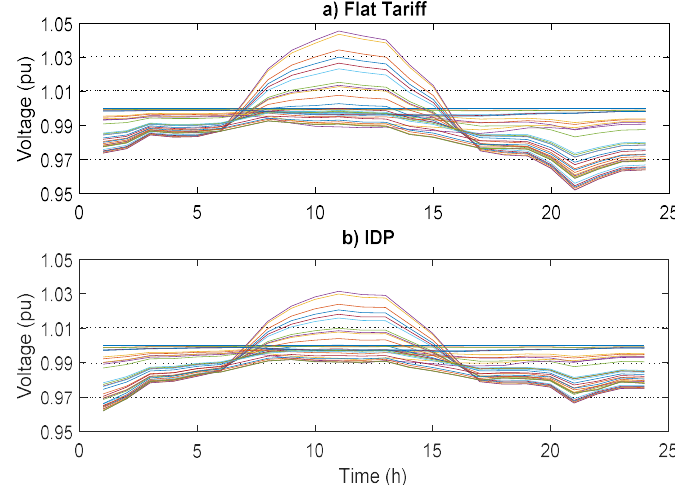
Figure 12. Voltage profile with PV generation. ( a ) Flat Tariff. ( b ) IDP.